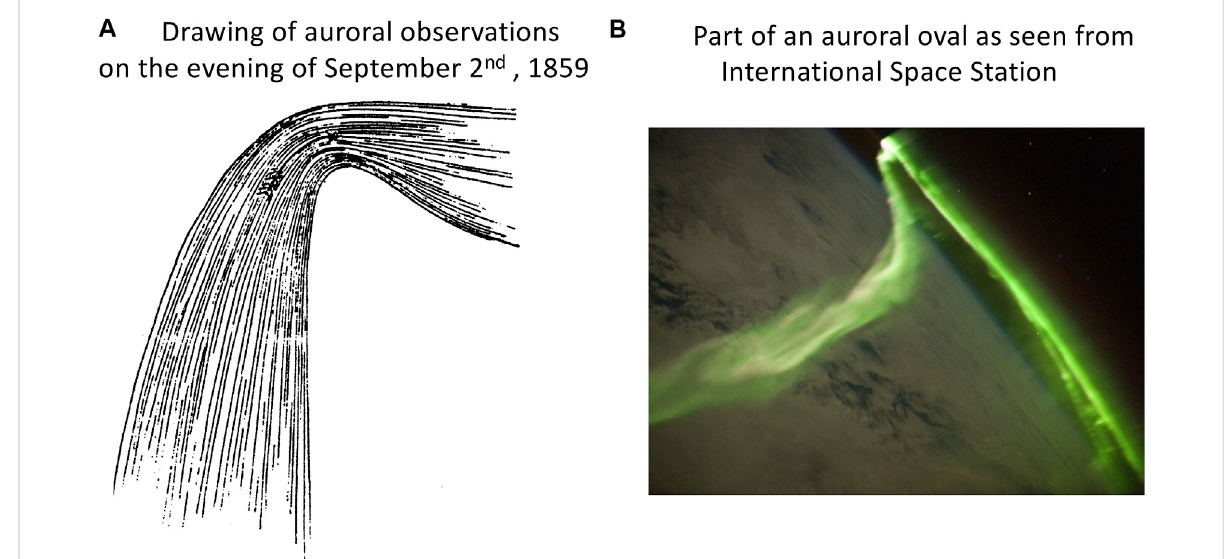
FIGURE 1 (A) A pictureoftheauroral displayon theevening of2September1859,Rome,N.Y. Lat.43deg13 mindesignedbyMr.Edward Huntington.The picture was originally published in a “ fi fth article on Great Auroral Exhibition ” by Prof. Elias Loomis, in the American Journal of Sciences, 1859 – 1861. Credit: COSPAR and Advances in Space Research. Source: Shea and Smart, 2006. (B) Part of an auroral oval as seen from the International Space Station, taken during a geomagnetic storm in 2010. Credit: NASA. Source: https://commons.wikimedia.org/wiki/File:Aurora_Australis_From_